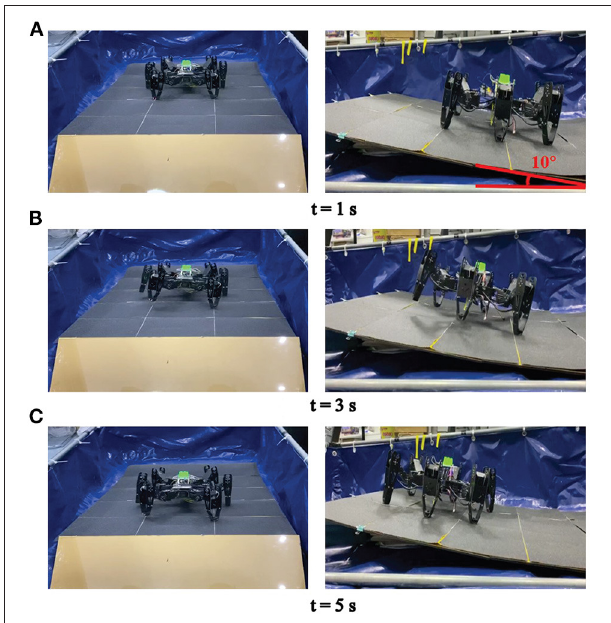
FIGURE 13 | The RL training experiment in an up-slope.